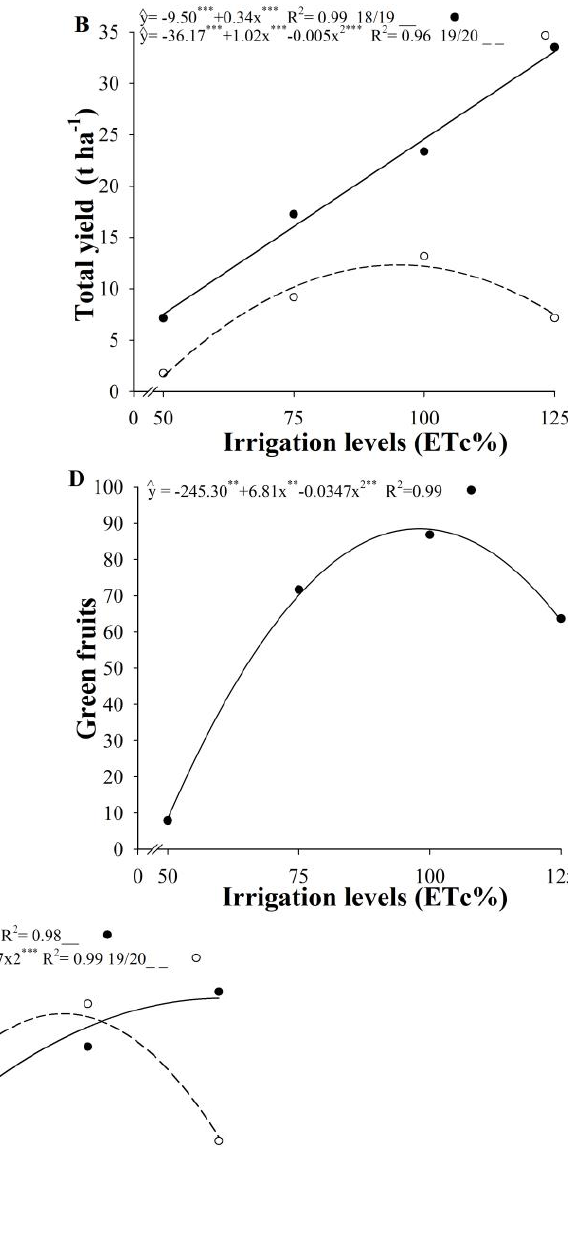
were not influenced between crop years ( p > 0.05) (Figure 4A). For the IWUE, there was a difference only for the Li of 125% ETc, with the first crop year (18/19) being 76.17% superior to the second (19/20) ( p < 0.001) (Figure 4B).